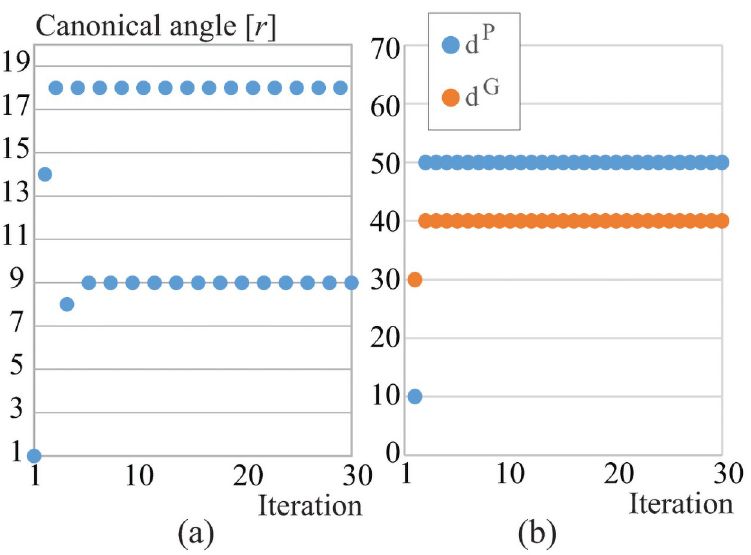
Fig 13. (a) Selected canonical angle r at each iteration by the boosting method, and (b) selected d G and d P at each iteration by the boosting method.